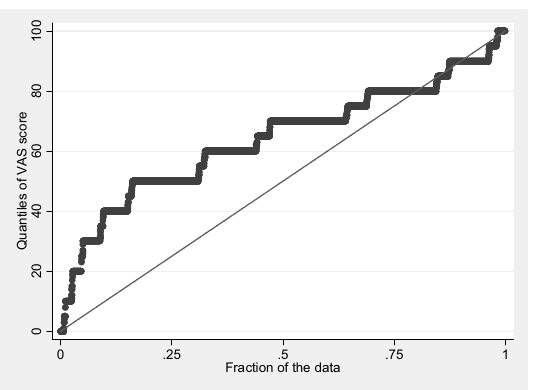
Figura 2 – Rappresentazione dei percentili della variabile